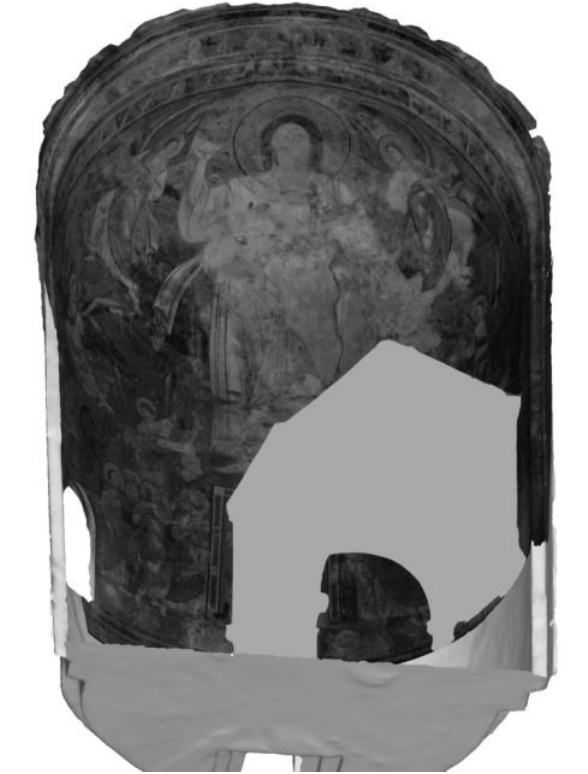
Figure 13. 3D model with texture extracted from the images acquired in 1954 used for the geometric recovering of the no more existing dome.